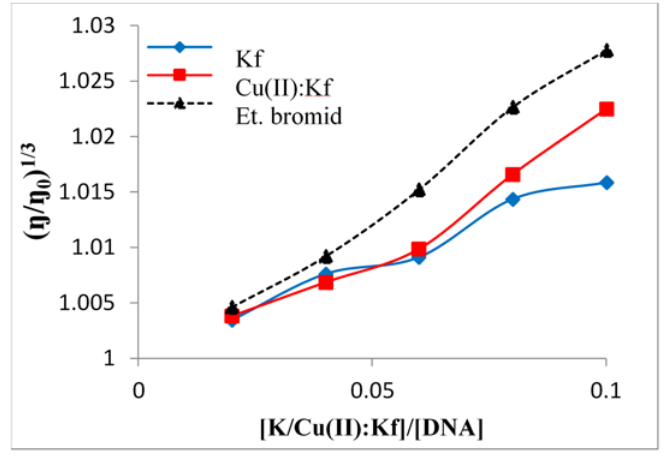
Figure 6. Relative viscosity of CT ‐ DNA in buffer (5 mM TRIS, 50 mM NaCl, pH 7.2) influenced by increasing concentration of free kaempferol and Cu ‐ kaempferol complex at 25 ± 0.1 °C compared to ethidium bromide (EtBr).